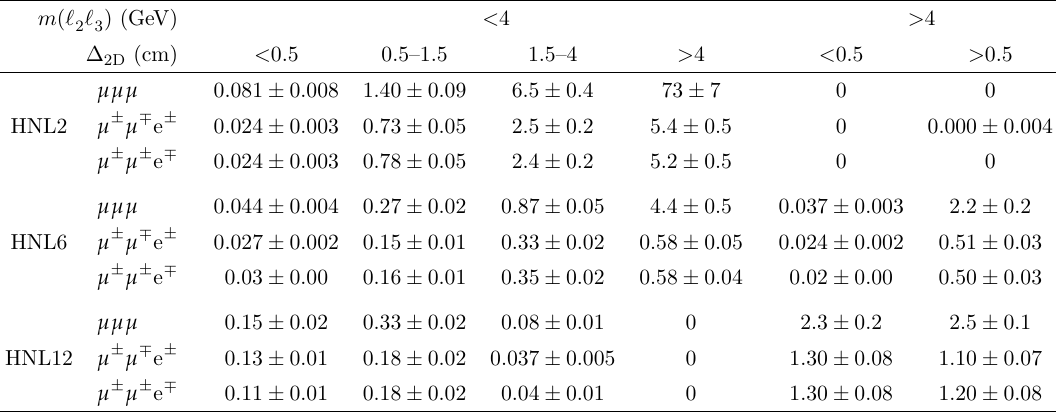
Table 6 . Number of predicted signal events in the mm X final states. The results are presented for several benchmark signal hypotheses for Majorana HNL production: m 0 . 8 × 10 − 4 (HNL2), m = 6 GeV and | V | 2 = 1 . 3 × 10 − 6 (HNL6), m N N ‘ 1 . 0 × 10 − 6 (HNL12). The quoted uncertainties include statistical and systematic